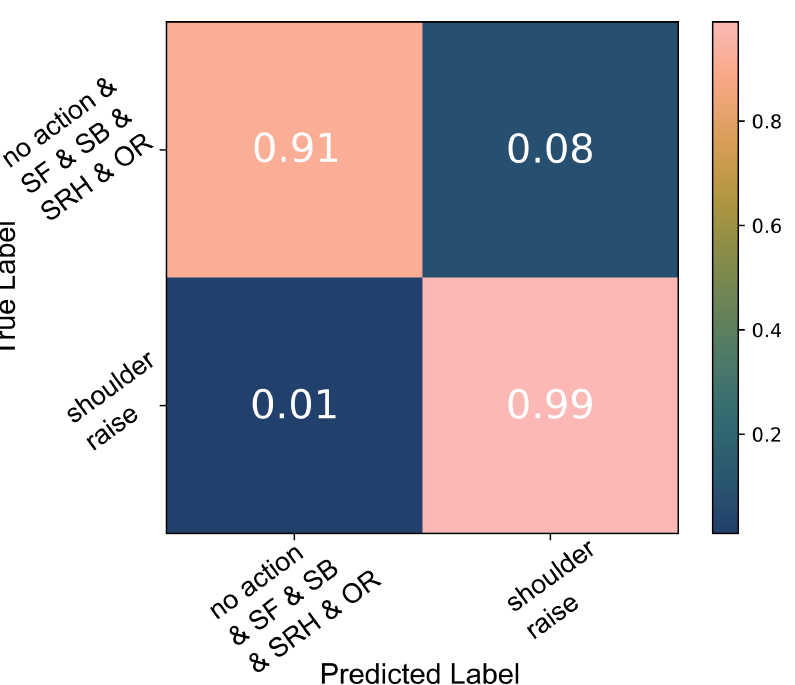
Figure 4. Decision tree classification results of able-bodied participants’ SR data; the model was tested against all data including the unknown SRH and OR action data.